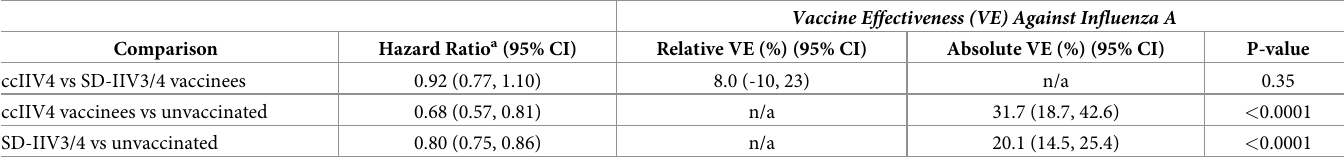
Table 2. Vaccine effectiveness against influenza A of cell culture and egg-based inactivated influenza vaccines among 4-64-year-olds, Kaiser Permanente Northern California 2017–18.